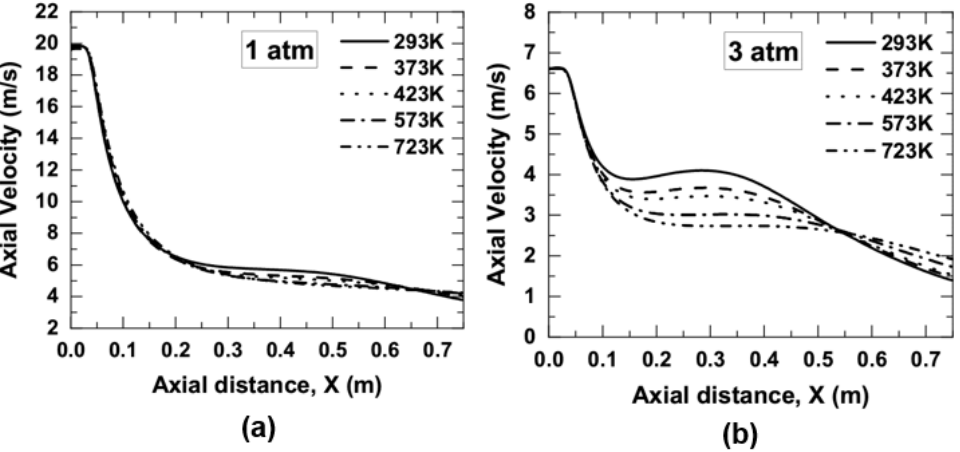
Figure 8. Axial velocity variation along the contour centerline as a function of air temperature; ( a ) 1 atm, and ( b ) 3 atm.